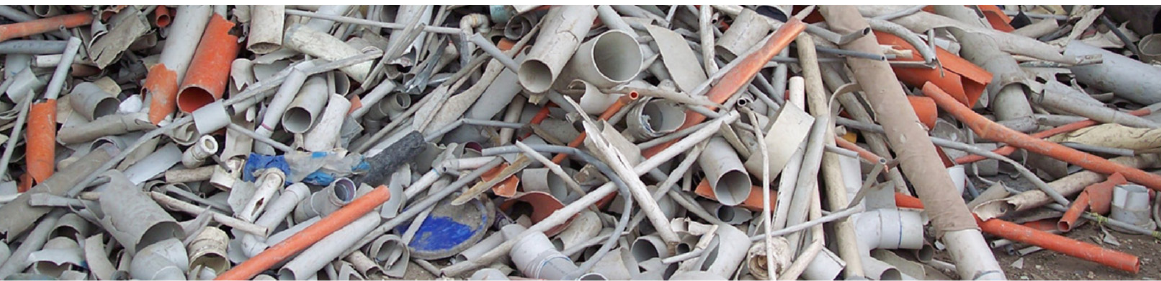
Figure 1. Construction waste (source: Australian Department of Agriculture, Water and the Environment [13]).